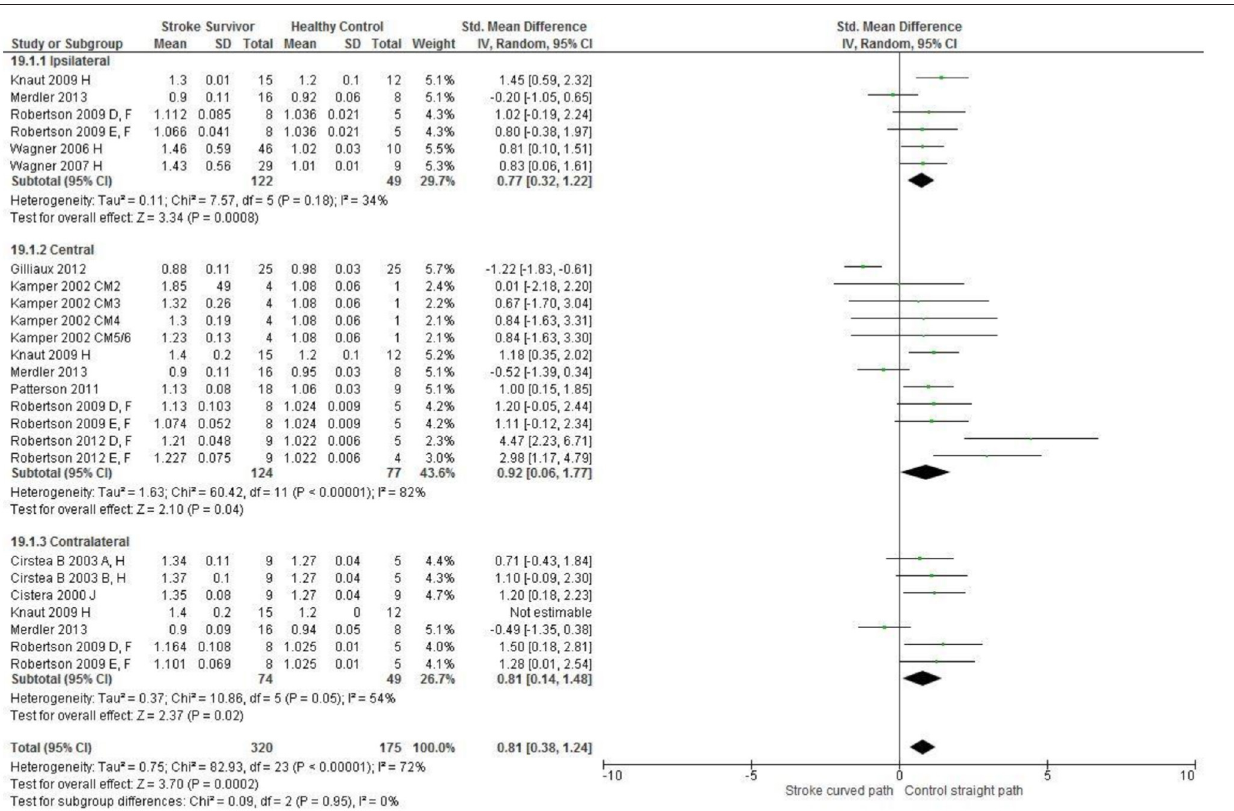
FIGURE 4 | The standardized mean difference (SDM) of reach-path ratio in the: ipsilateral, central, and contralateral workspace. A, mild motor impairment; B, moderate motor impairment; D, right hemisphere stroke; E, left hemisphere stroke; F, target placed 90% of arm’s length; H, fast speed; J, reaches without vision; CM, Chedoke-McMaster Stroke Assessment Scale; and corresponding stage